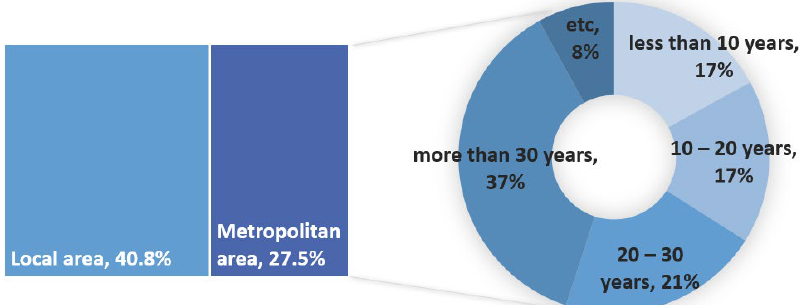
Figure 2. Age analysis of existing buildings in Korea [10]; values as of November